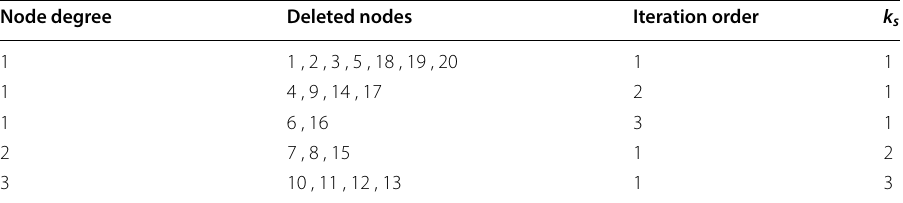
Table 1 The iteration process of k-shell decomposition Node